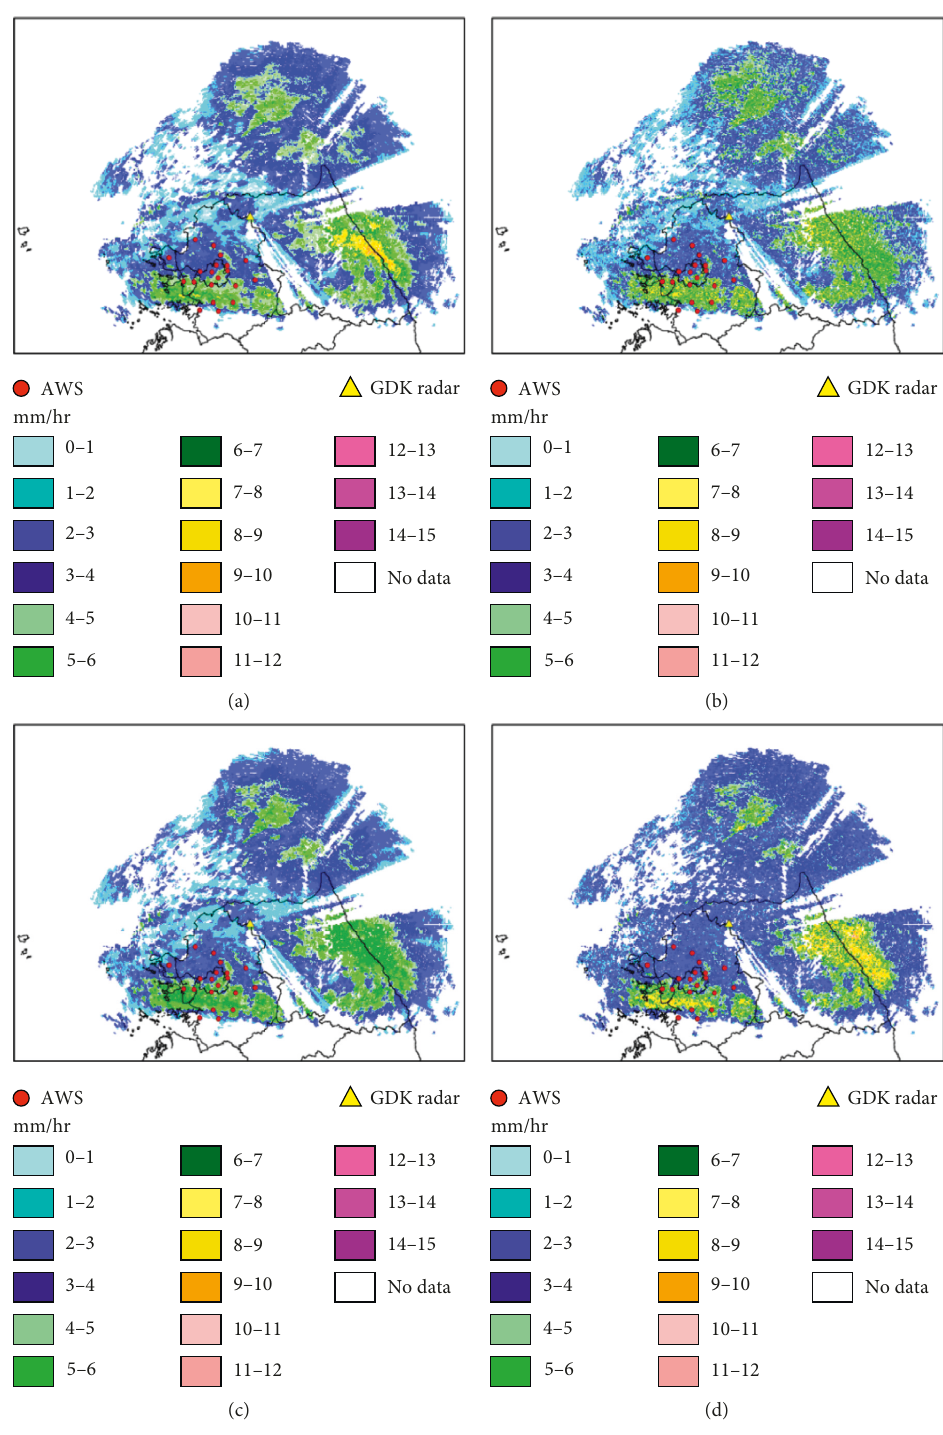
Figure 8: Radar rainfall rate fields of four selected quantitative precipitation estimation models (ZR2–L1, RF5, GBM2, and ELM5) for event #4 (November 8, 2018; 12: 40). (a) ZR2-L1. (b) RF5. (c) GBM2. (d)